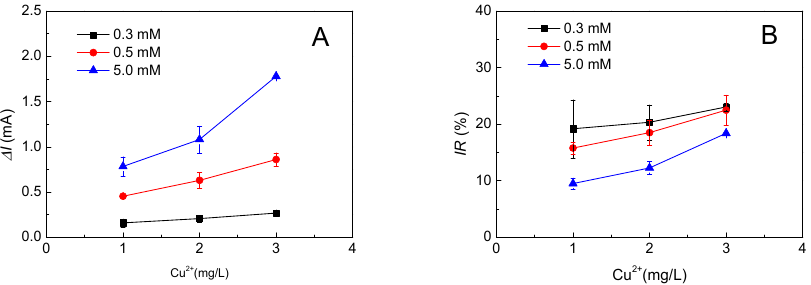
Figure 2. The background organic matter concentration affects the toxicity monitoring: ( A ) the effect of background organic matter concentration on the current change ( Δ I ) of the MFC sensor for toxicity monitoring; ( B ) the effect of background organic matter concentration on the inhibition ratio (IR) of the MFC sensor for toxicity monitoring.